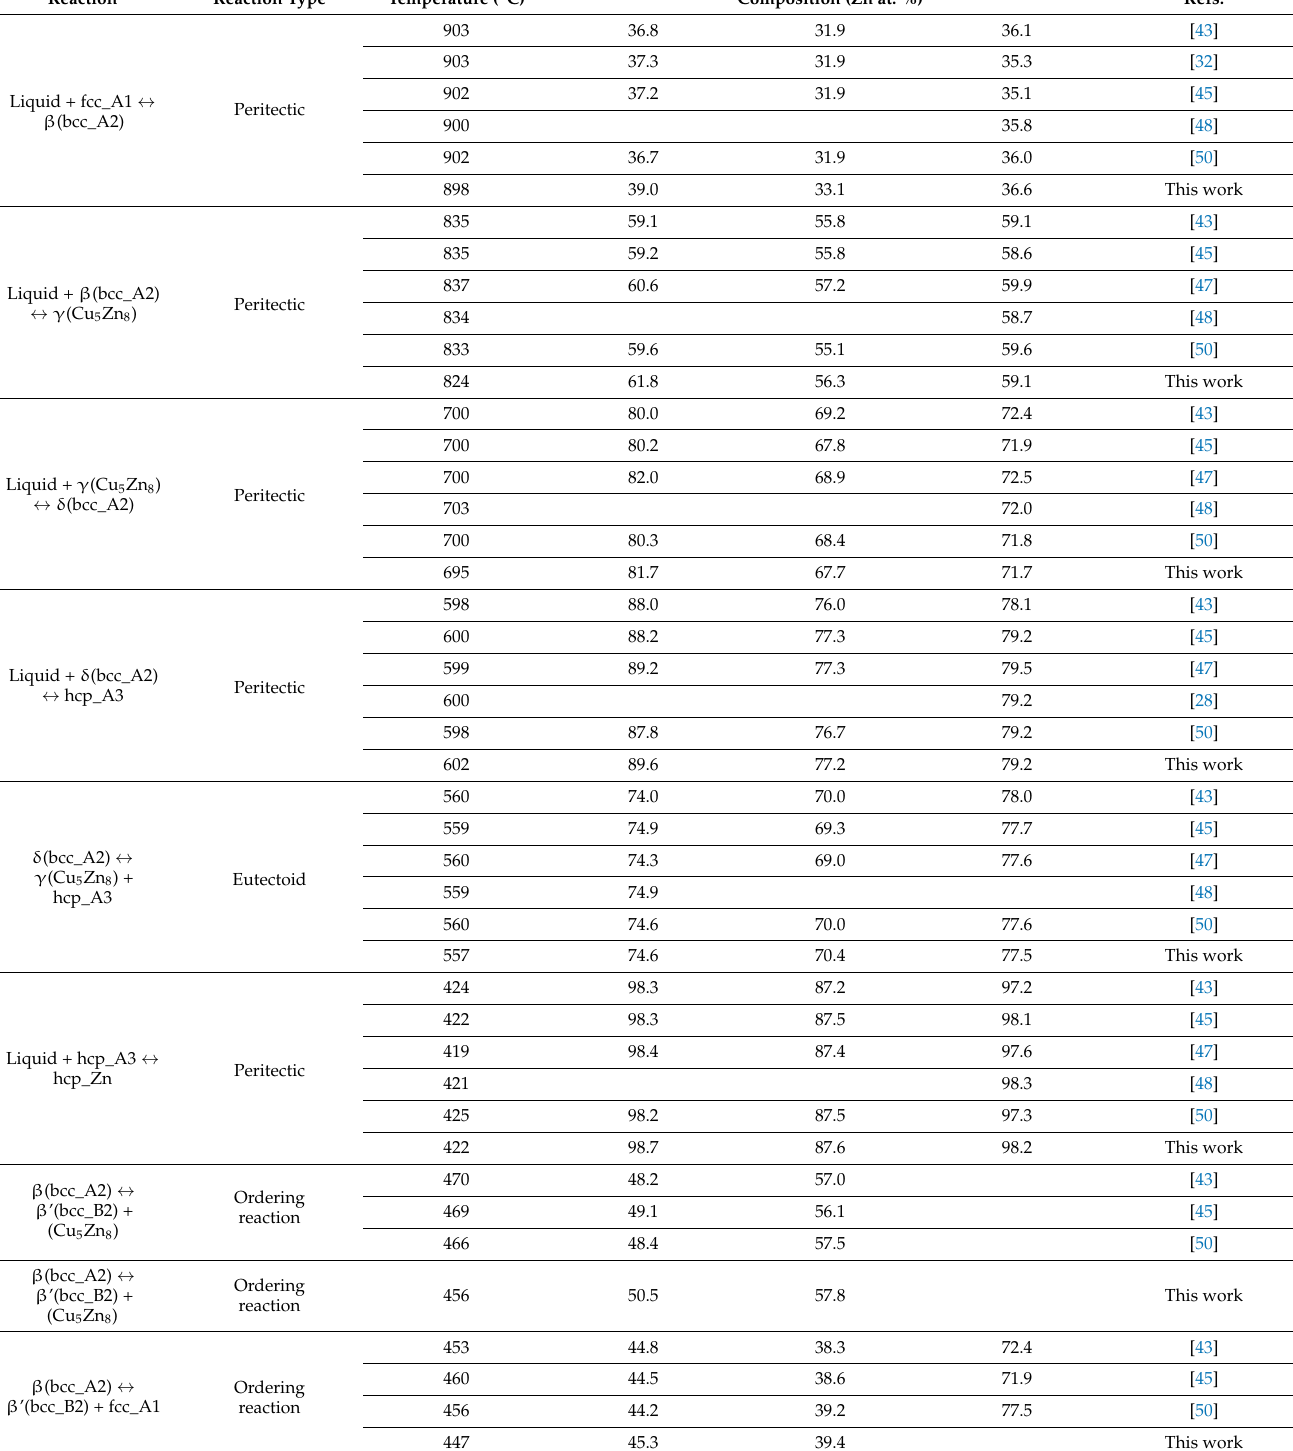
Table 7. The calculated invariant reactions in the Cu-Zn system compared with the experimental data from ref. [44] and calculated data from refs. [45,47,48,50]. Composition (Zn at. %)